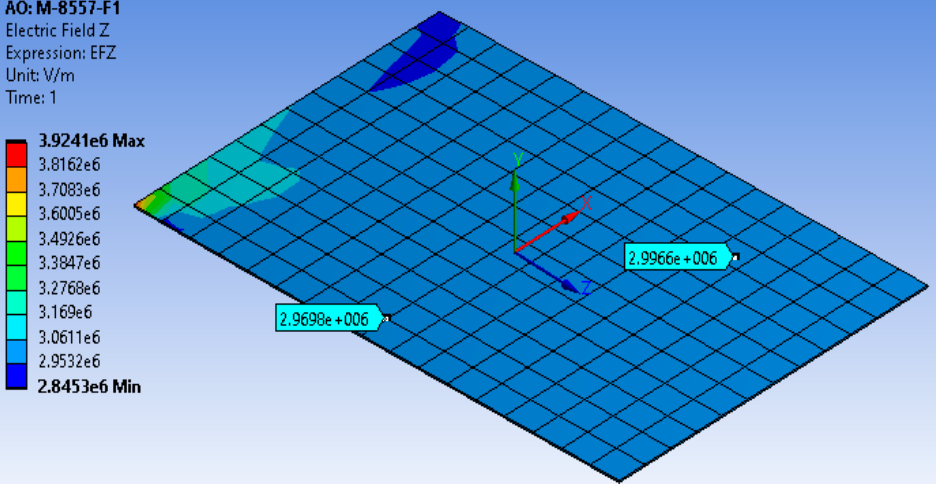
Figure 7. Simplified FE model of the electric field generated from the applied voltage difference of 255,000 V, which is equivalent to 1500 V in the physical MFC.